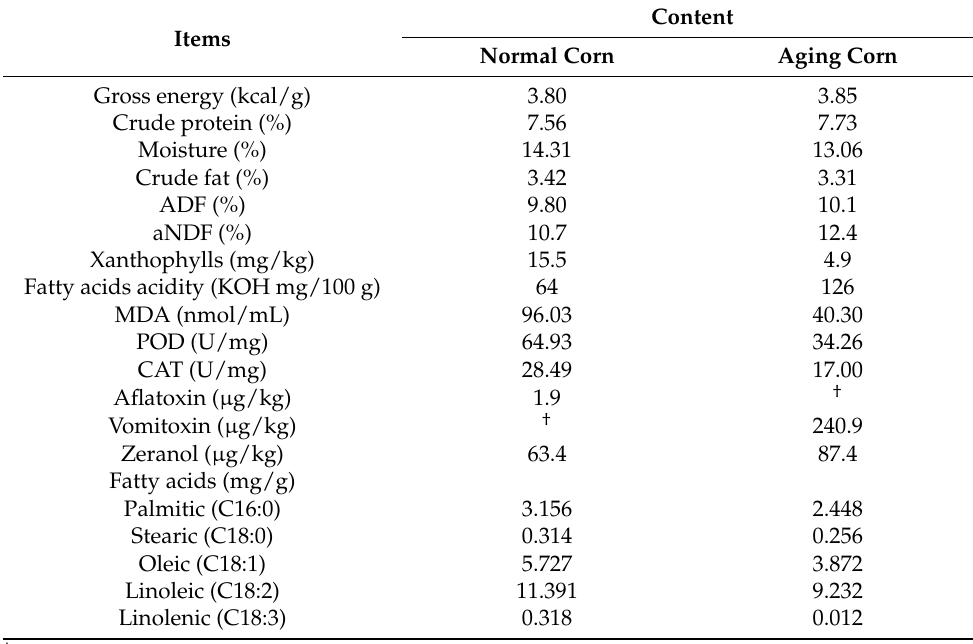
Table 2. Phytochemical properties of normal and aging corn (air-dried basis).